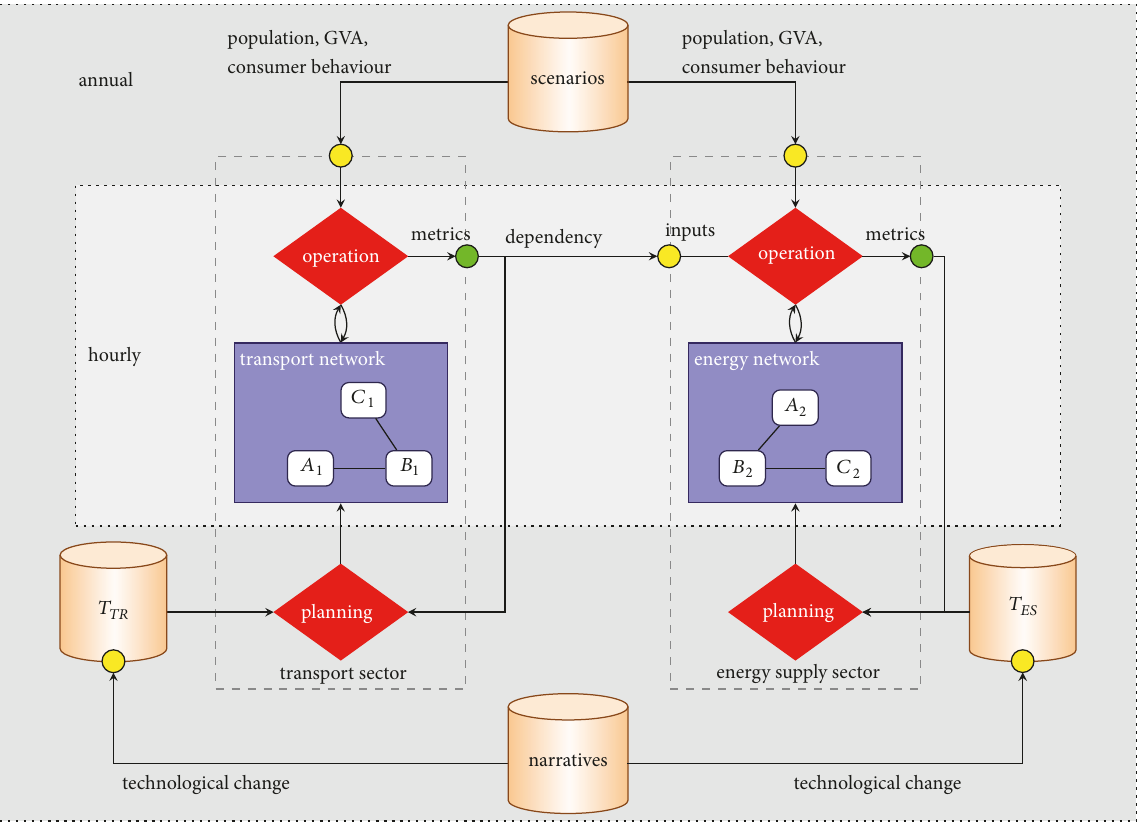
Figure 1: A dependency shown between just two infrastructure sectors contained in the ITRC’s National Infrastructure System Model. The cylinders labelled 𝑇 𝑡𝑟 and 𝑇 𝑒𝑠 represent the stock of available technologies for the transport and energy sectors. Narratives hold the collection of assumptions exogenous to the modelled system about long-term technological changes and modify the attributes of available technologies. Scenarios capture changes in socioeconomic drivers of infrastructure service demands. The network structure that underpins the hourly operation of the sector is altered over annual planning timescales as technology changes, and long-term planning investments result in the turnover of the infrastructure stock. Performance metrics produced from the operation of the system simulation feed back into the planning strategies governing future investments and provide the results of a model